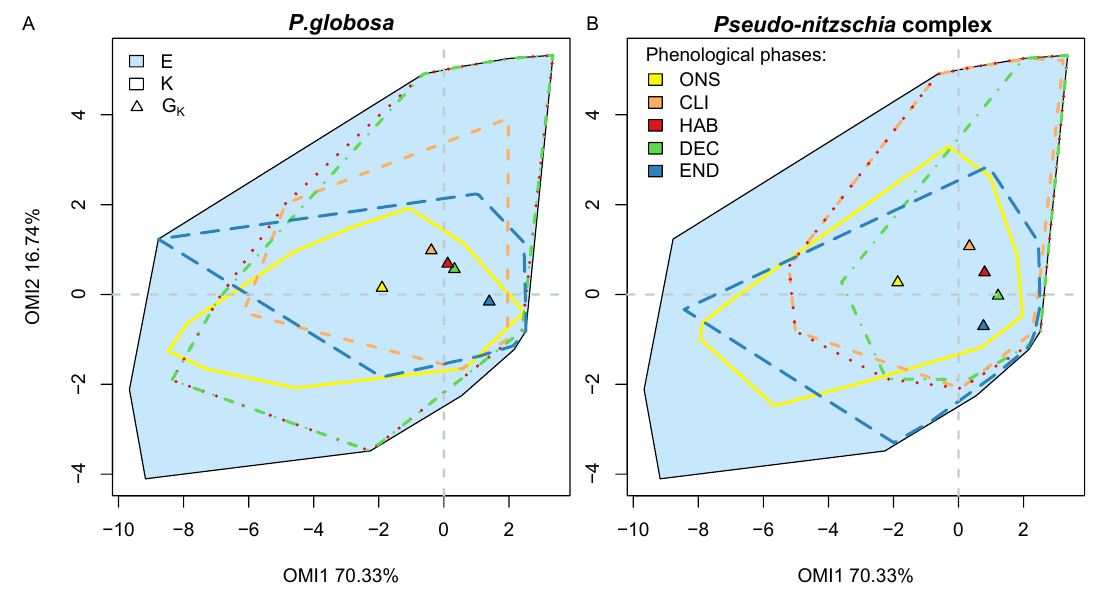
Figure 8. A biplot representing the distribution of the 5 environmental subsets, K, defined by the phenological stages onset (ONS: the full yellow contour), climax (CLI: dashed orange contour), harmful stage (HAB: red dotted contour), decline (DEC: green dash and dotted contour) and end (END: the blue dashed contour). Each subset has their respective mean position (G K ) represented by a triangle of the same color. All subsets are enclosed within the environmental space E (light blue polygon). ( A ) are the different environmental subsets for P. globosa and ( B ) for the complex of Pseudo-nitzschia